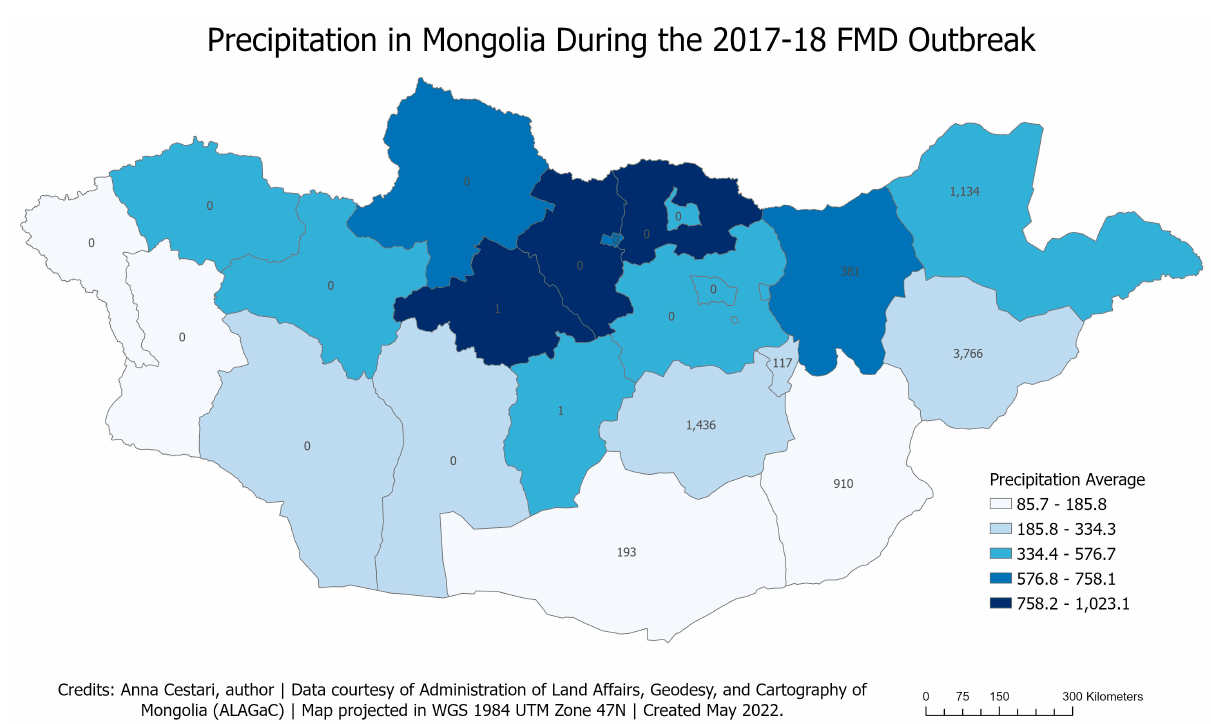
Figure 11. This map shows the provinces in Mongolia with color shading based on the amount of precipitation. The darker colors represent more precipitation. Each province is labeled with its number of foot and mouth disease cases for